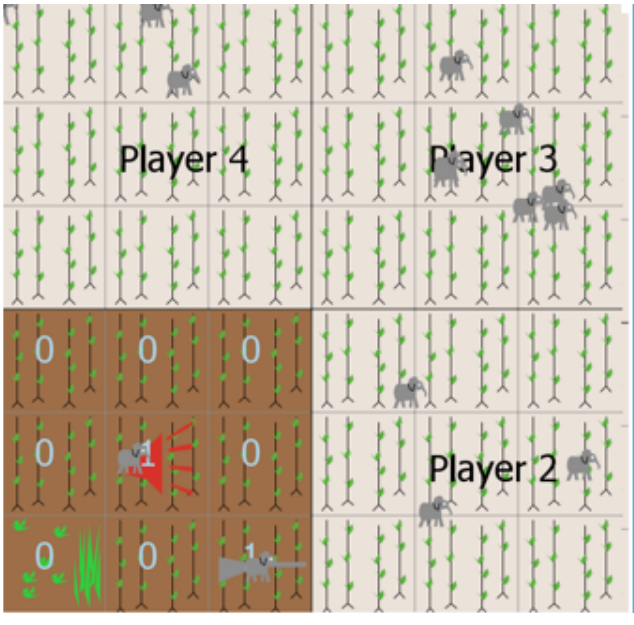
Figure: Bottom left corner of the landscape is active